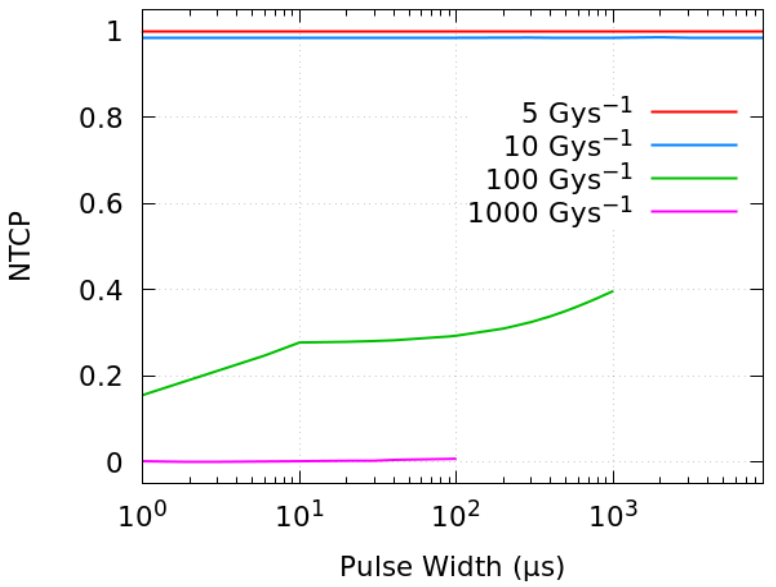
correspond to a total dose of 10 Gy delivered at 100 Hz.